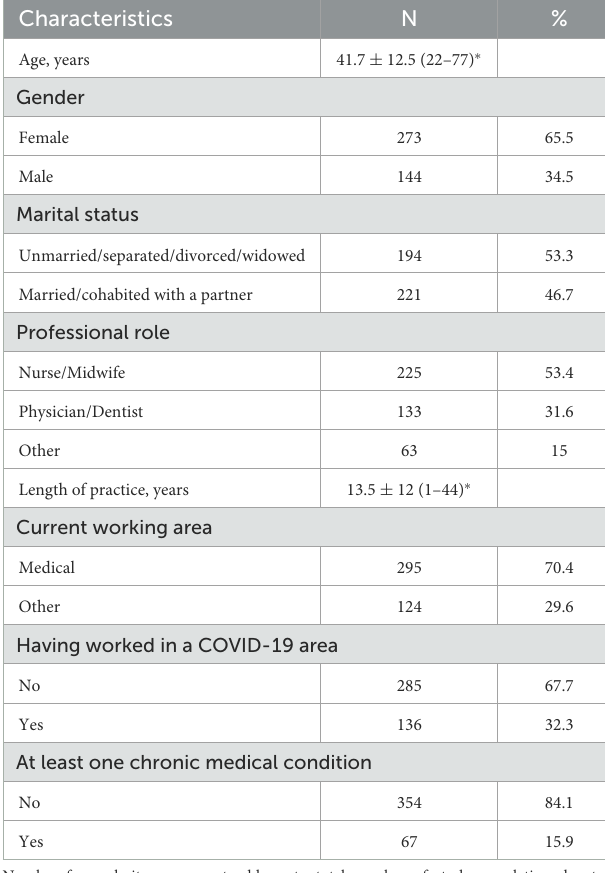
TABLE 1 Main socio-demographic, general, and professional characteristics of the sample.